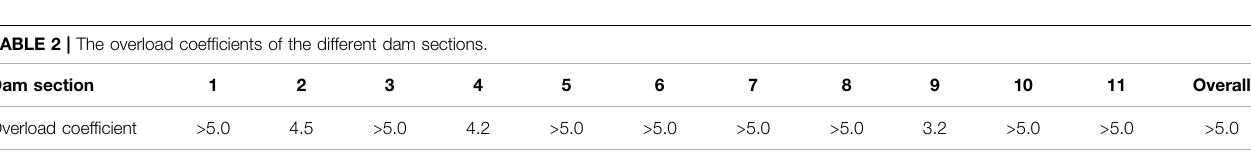
TABLE 2 | The overload coef fi cients of the different dam